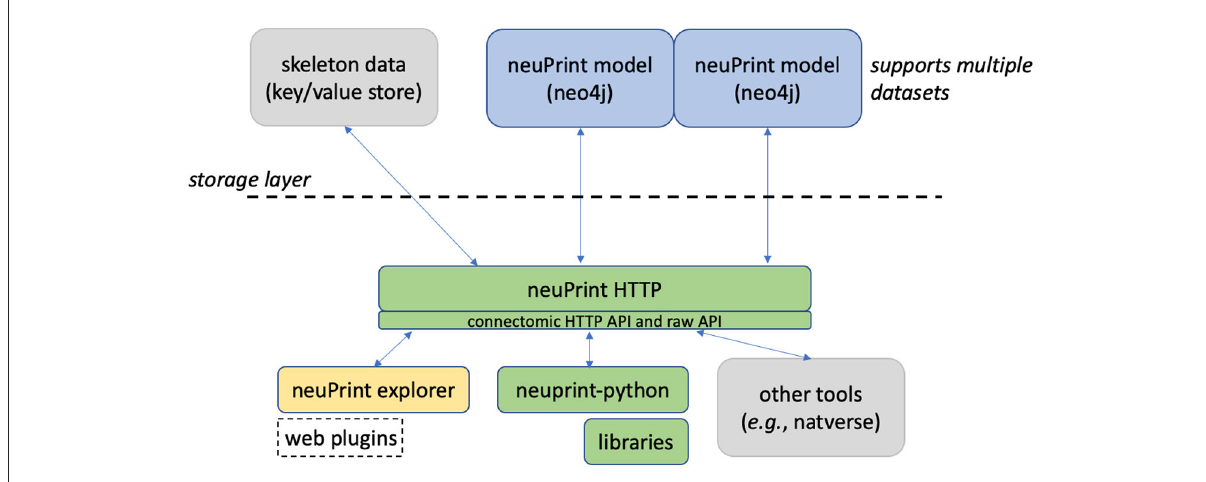
FIGURE1 neuPrint ecosystem. The ecosystem is broadly divided into a lower-level data representation and storage above the dashed line and a higher-level interface below the dashed line.